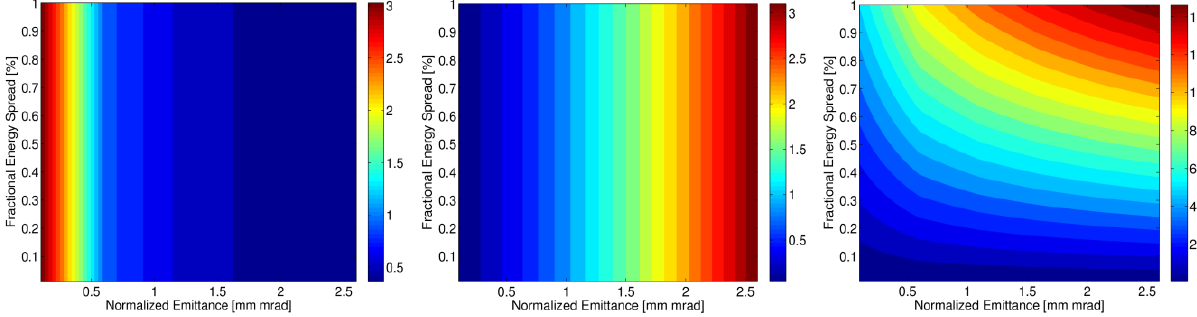
and  as function of electron bunch  